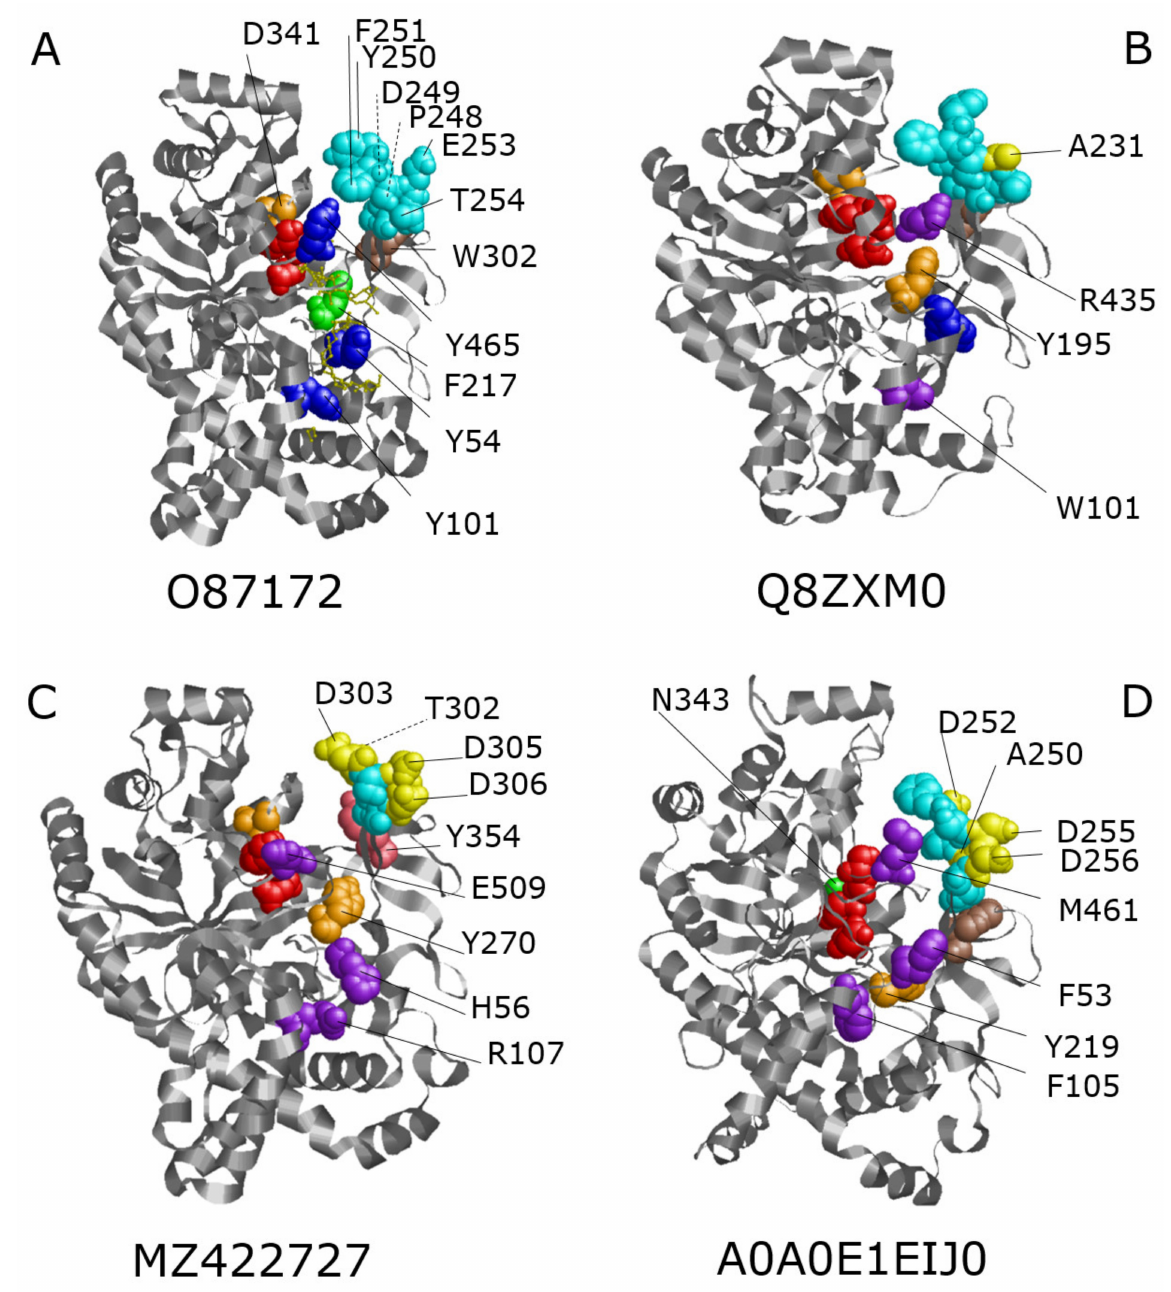
Figure 6. 3D structures of selected amylomaltases and amino acids of conserved regions. The reported structures refer to amylomaltases O87172 from T. thermophilus ( A ), Q8ZXM0 from P. aerophilum ( B ), MZ422727 from H. walsbyi ( C ) and A0A0E1EIJ0 from S. agalactiae ( D ). See also Table S2 for amino acids positions. The dashed lines indicate amino acids located at the rear of the structure. Coloured spacefillings are explained in the text. In the structure of the T. thermophilus enzyme, molecules of acarbose (a maltotetraose derivative, acting as an inhibitor of enzymes of the a-amylase family and usually used for studying possible binding modes for large amylose substrates [57]) are also